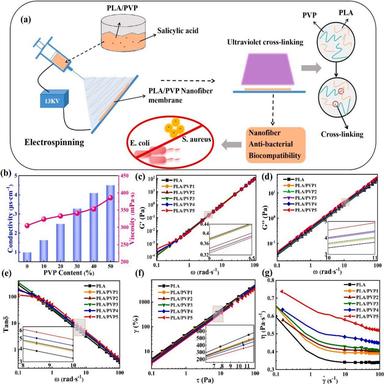
Performance of PLA/PVP solution (a) Schematic illustration of electrospinning PLA/PVP crosslinked drug-loaded nanofiber membranes. (b) Electrical conductivity and viscosity data, (c) storage modulus, (d) loss modulus, (e) loss factor, (f) shear strain with stress and (g) viscosity with shear rate.